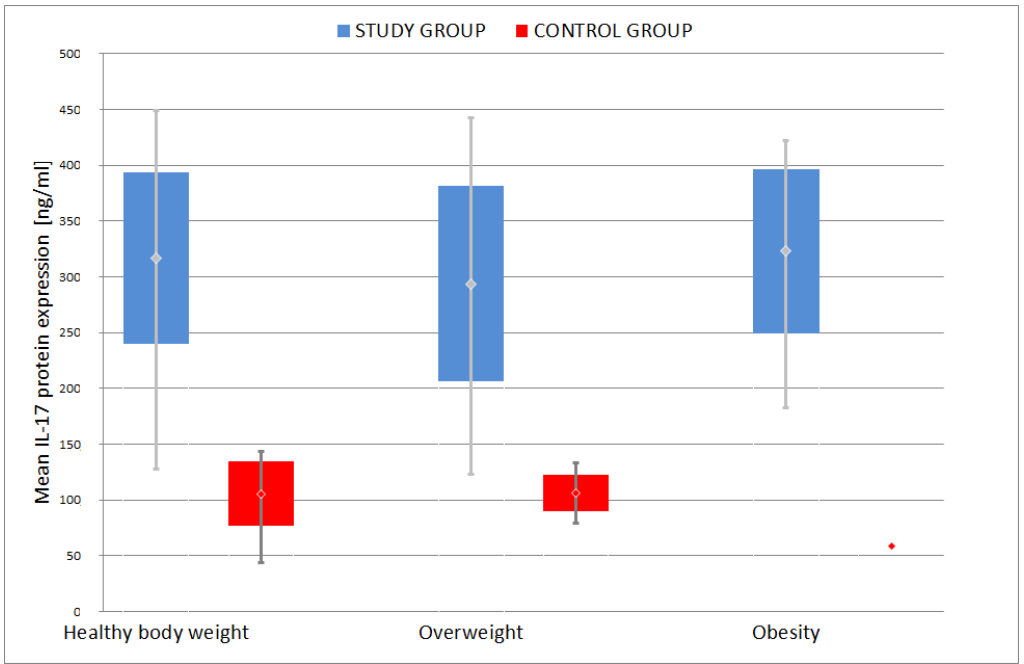
Figure 6. Comparison of mean IL-17 protein expression among different weight groups.